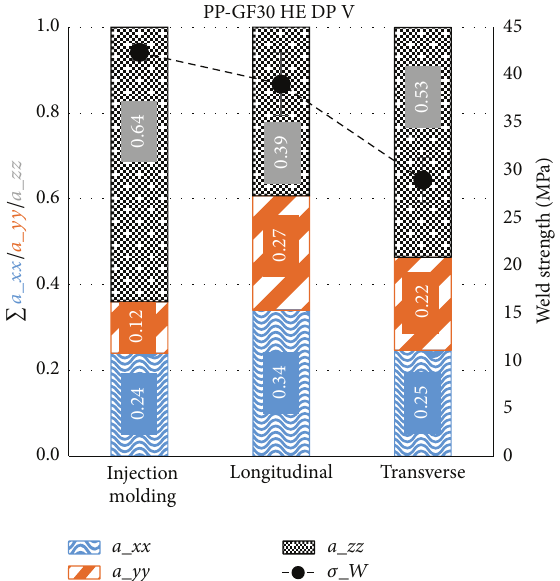
Figure 23: Fiber orientation and weld strength in hot plate welding of PP-GF30 for different initial fiber orientations.